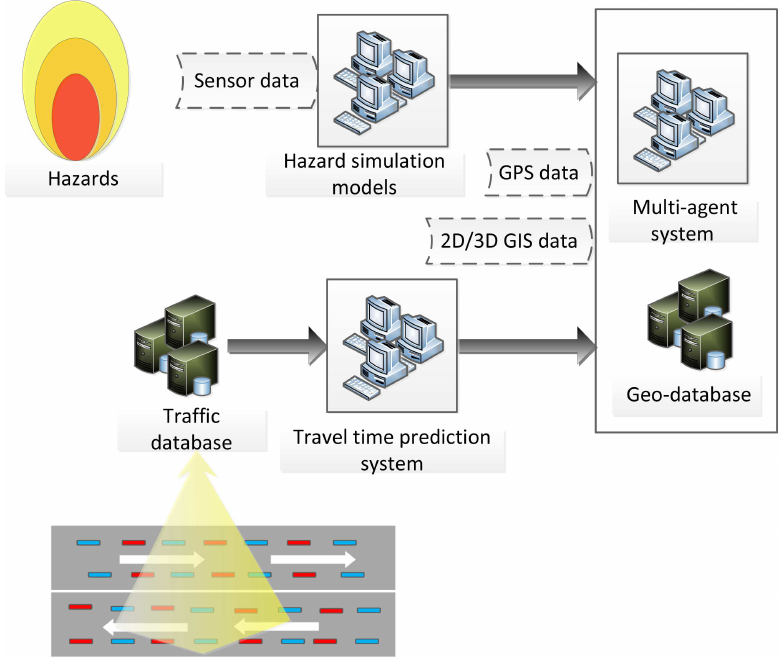
Figure 1. Overview of the generic system